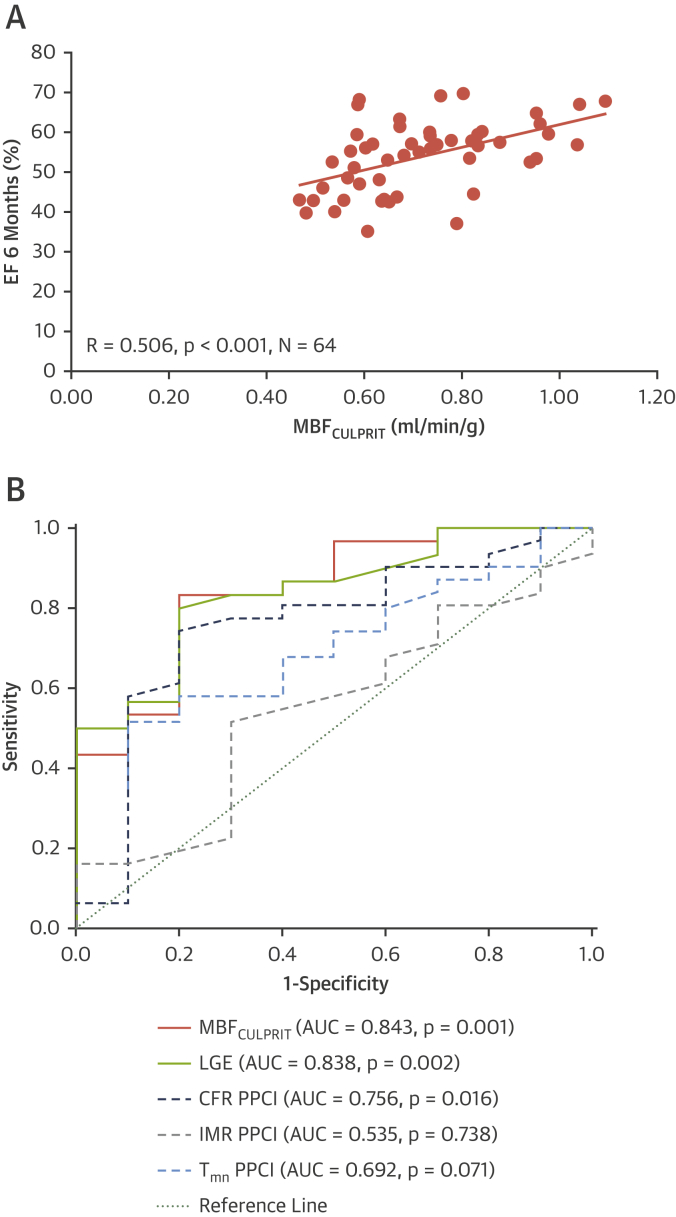
Relationship Between Acute MBFCULPRIT and EF 6M(A) Per patient analysis. (B) Receiver-operating characteristic curves showing the diagnostic performance of acute average myocardial blood flow in the culprit territory (MBFCULPRIT) and late gadolinium enhancement (LGE), index of microvascular resistance (IMR), coronary flow reserve (CFR), and transit time at rest (Tmn) in predicting left ventricular (LV) dysfunction (ejection fraction [EF] <50%) at 6 months (6M) in patients with index of microvascular resistance <40 or coronary flow reserve >2 at the time of primary percutaneous coronary intervention. AUC = area under the curve; PPCI = primary percutaneous coronary intervention.